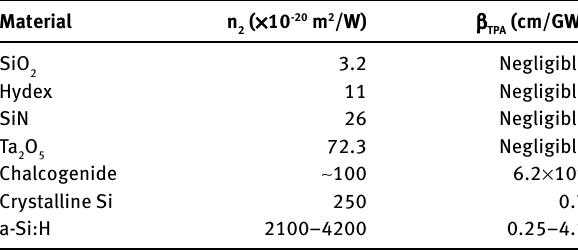
Table 1 Nonlinear refractive indices and two-photon absorption coefficients of various materials [116, 118, 121, 126, 127,